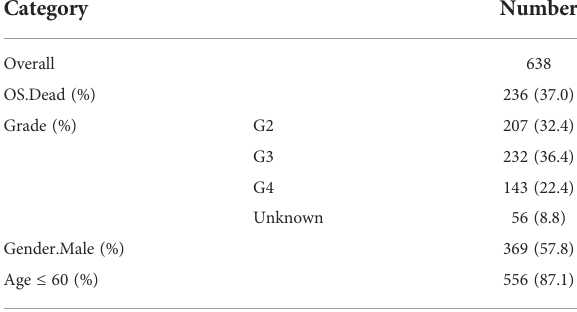
TABLE 1 Glioma patients with clinical data in